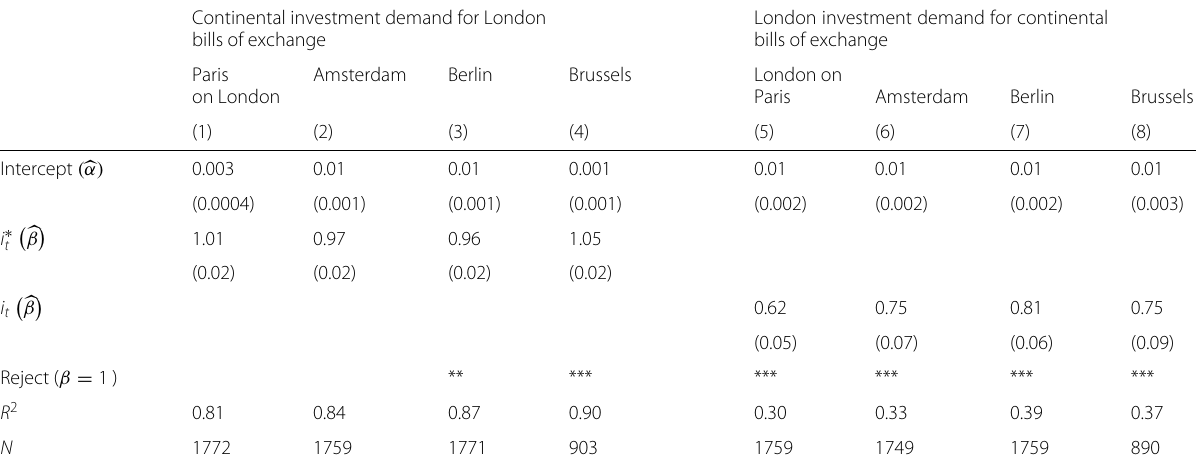
Table 2 Results: Interest parity via long-bills of exchange Continental investment demand for London bills of